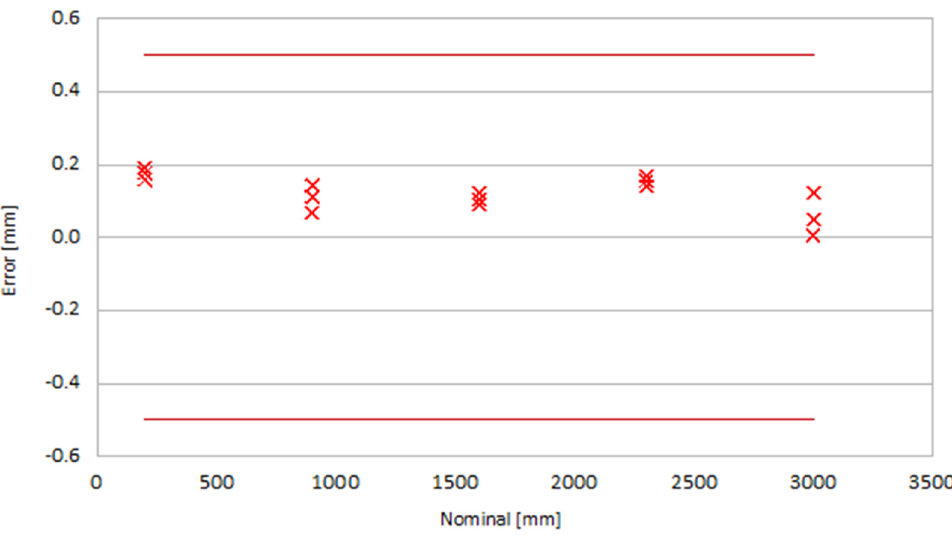
Figure 9. XZ1 − axis measurement error characteristic. Table 5. Measurement errors of the XZ2 axis.